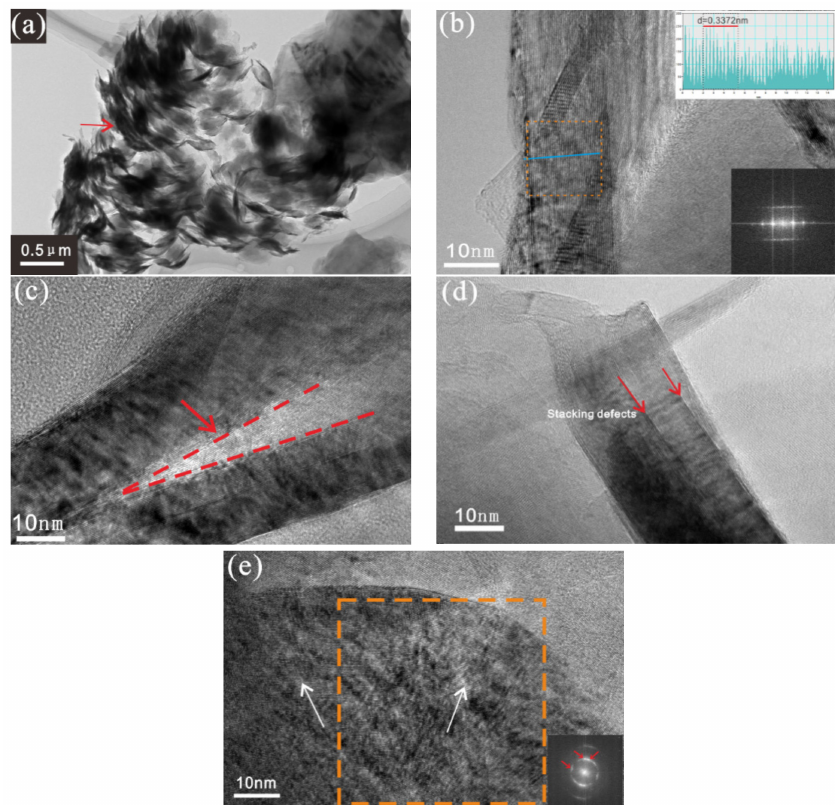
Figure 5. ( a ) Sample D60 showing scaly graphite particles. ( b ) Sample D60 showing straight carbon layers; the inset in the upper right corner shows the lattice intensity profile along the blue line, and the fast Fourier transform (FFT) image of the region of interest (ROI) is at the bottom right. ( c ) Sample B1-1 showing delamination of interlayers. ( d ) Sample B1-1 showing stacking defects. ( e ) Sample F1-1 showing bending layers due to the dislocation vertical to the basal plane (arrows point the dislocation wall); the inset at the bottom right shows the FFT image of the